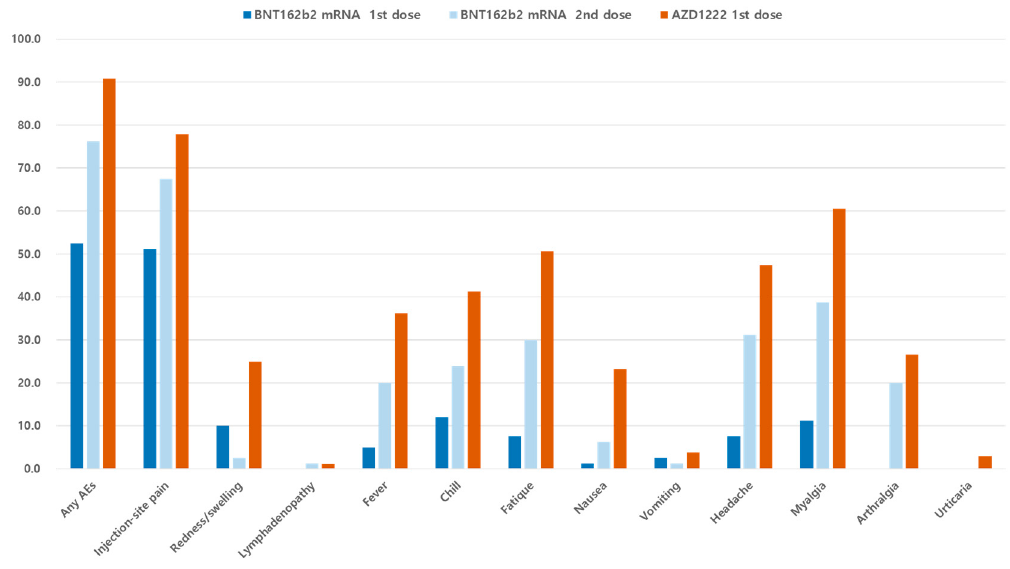
Figure 1. Incidence of reported adverse events in the first and the second vaccine recipients. AEs, adverse events. Table 2. C linical characteristics of vaccine recipients with adverse events.